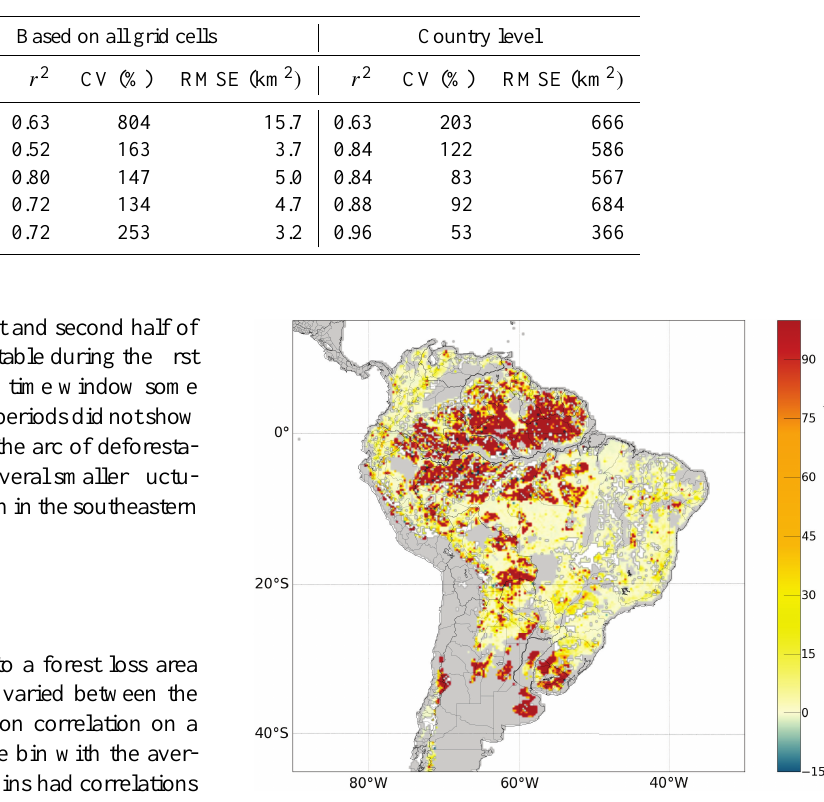
Figure 4. Error estimates for each grid cell. The error is defined as VOD minus GFC forest loss area expressed as a percentage of GFC for the overlapping time period. White indicates that both data sets had no forest loss.